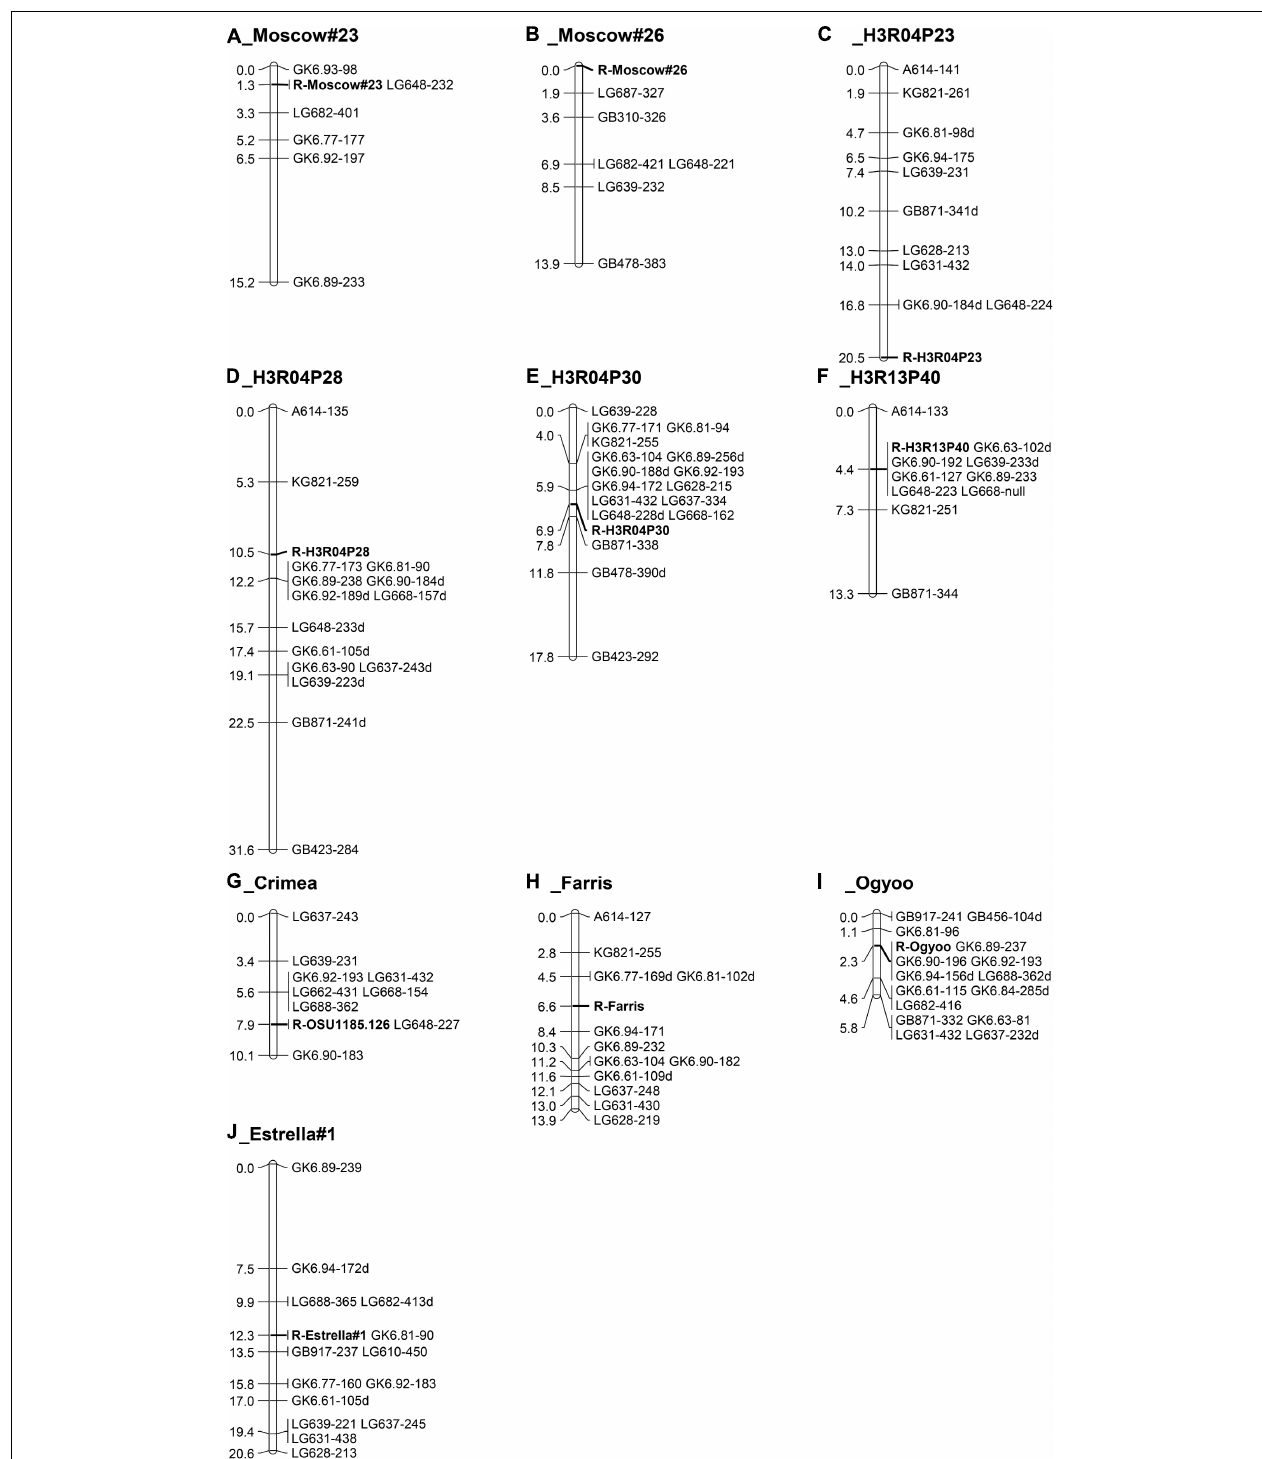
FIGURE 3 | Maps of linkage group 6 (LG6) in hazelnut populations segregating for eastern filbert blight resistance from ten parents. (A) progeny 12028 for resistance from Moscow #23, (B) progeny 12029 for resistance from Moscow #26, (C) two progenies for resistance from H3R04P23 (RUS-13, Holmskij, Russia), (D) progeny 14029 for resistance from H3R04P28 (RUS-13), (E) progeny 14030 for resistance from H3R04P30 (RUS-13), (F) progeny 14036 for resistance from H3R04P30 (RUS-9, Holmskij, Russia), (G) progeny 11025 for resistance from OSU 1185.126 (RUS-26, Simferopol, Crimea), (H) two progenies for resistance from Farris OSU 533.029, (I) progeny 10021 for resistance from C. heterophylla ‘Ogyoo’, and (J) progeny 11520 for resistance from ’Estrella #1’.